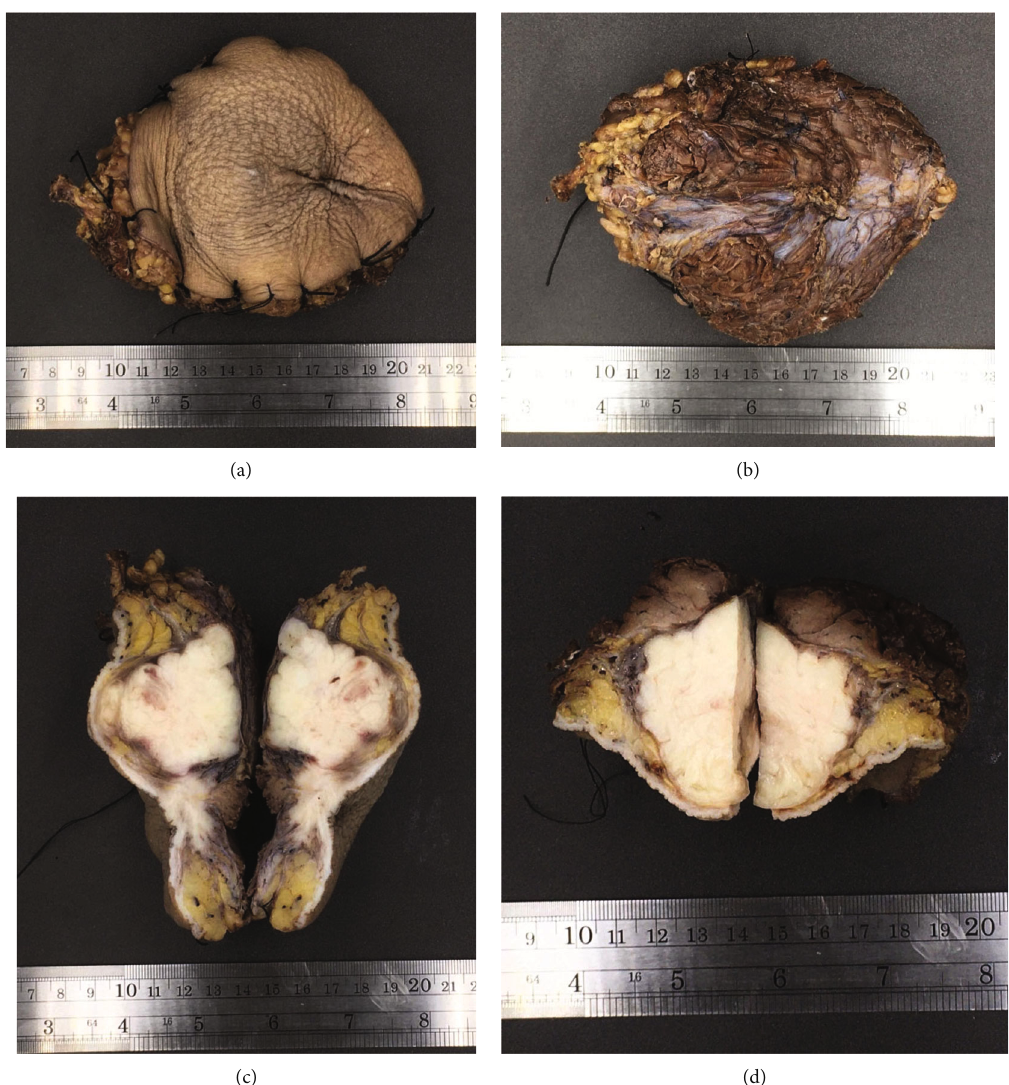
Figure 5: Gross specimens. (a) Posterior part. (b) Anterior part. (c) Medial section (saggital plane). (d) Superior section (transverse